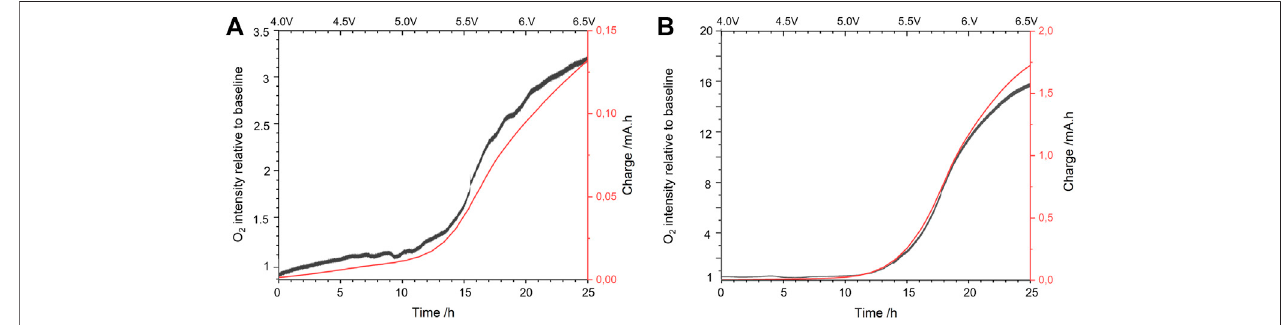
FIGURE6 | Operando O 2 sensing measurementsfor (A) LAGP and (B) LATP coupled to accelerated PITT in oxidation. SE-Au/SE stacks ofLAGP and LATP were usedwithinthree-outletSwagelokcells.TheacceleratedPITTispresentedasthechargeQasafunctionoftime.Apotentialstepof100 mV,acurrentlimitof10 nAanda time limit of 1 h were used.